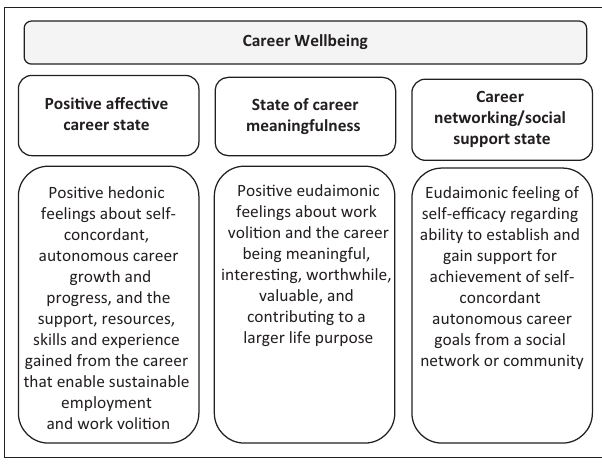
FIGURE 1: Multidimensional facets of the Career Well-being